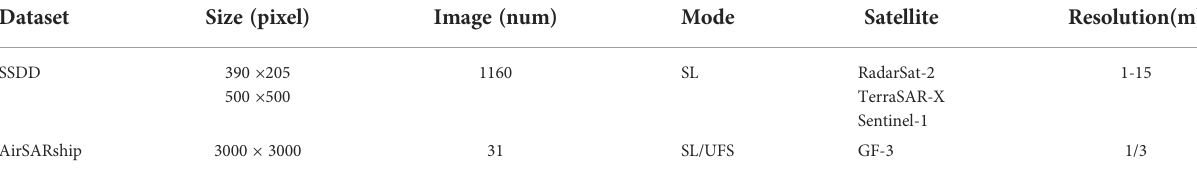
TABLE 1 Reveal the dataset ’ s complete